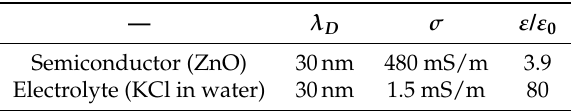
Table 1. Values for the physical properties of the liquid and the semiconductor (ZnO) sphere in Figure 2. Values for ZnO are within the range reported in [39].